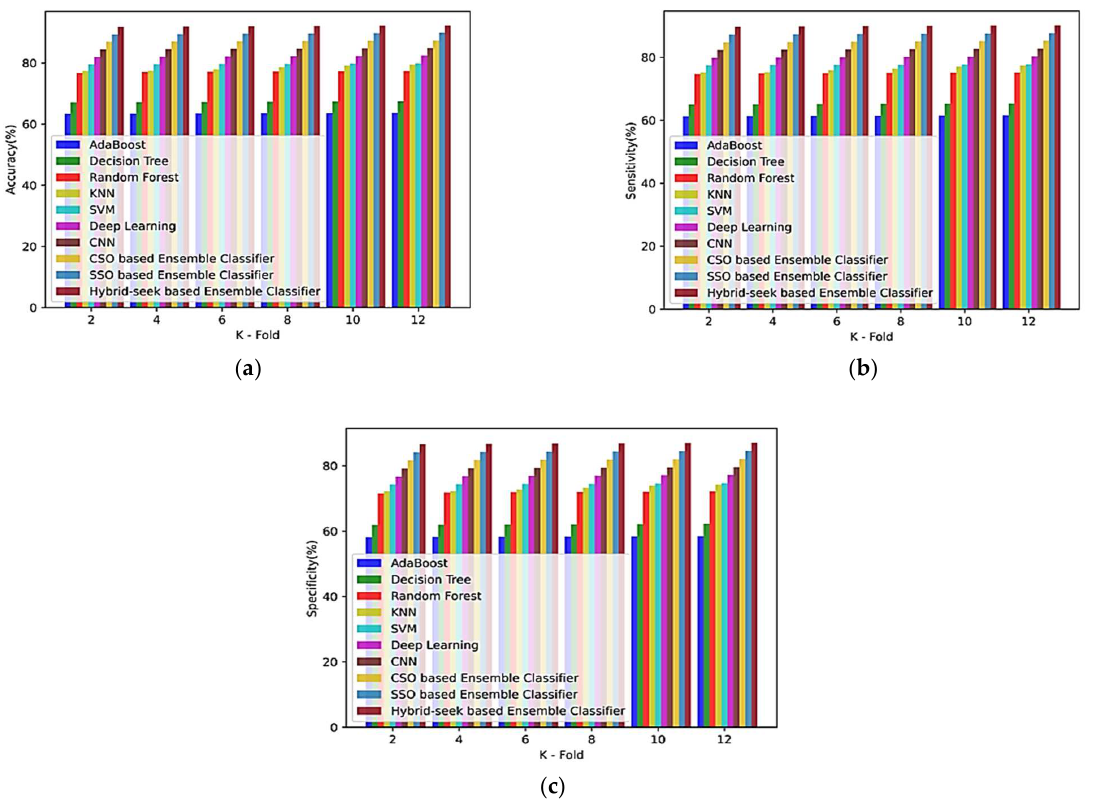
Figure 11. Comparison of k-fold values of Siena Scalp database with other classifiers for ( a ) accuracy, ( b ) sensitivity, and ( c ) specificity.